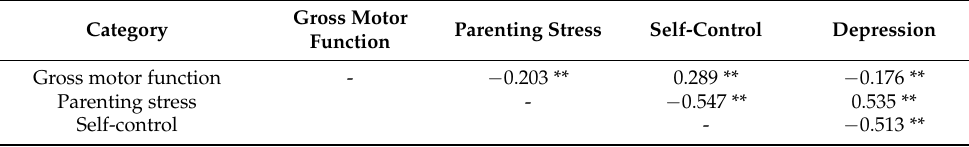
Table 2. Correlation between